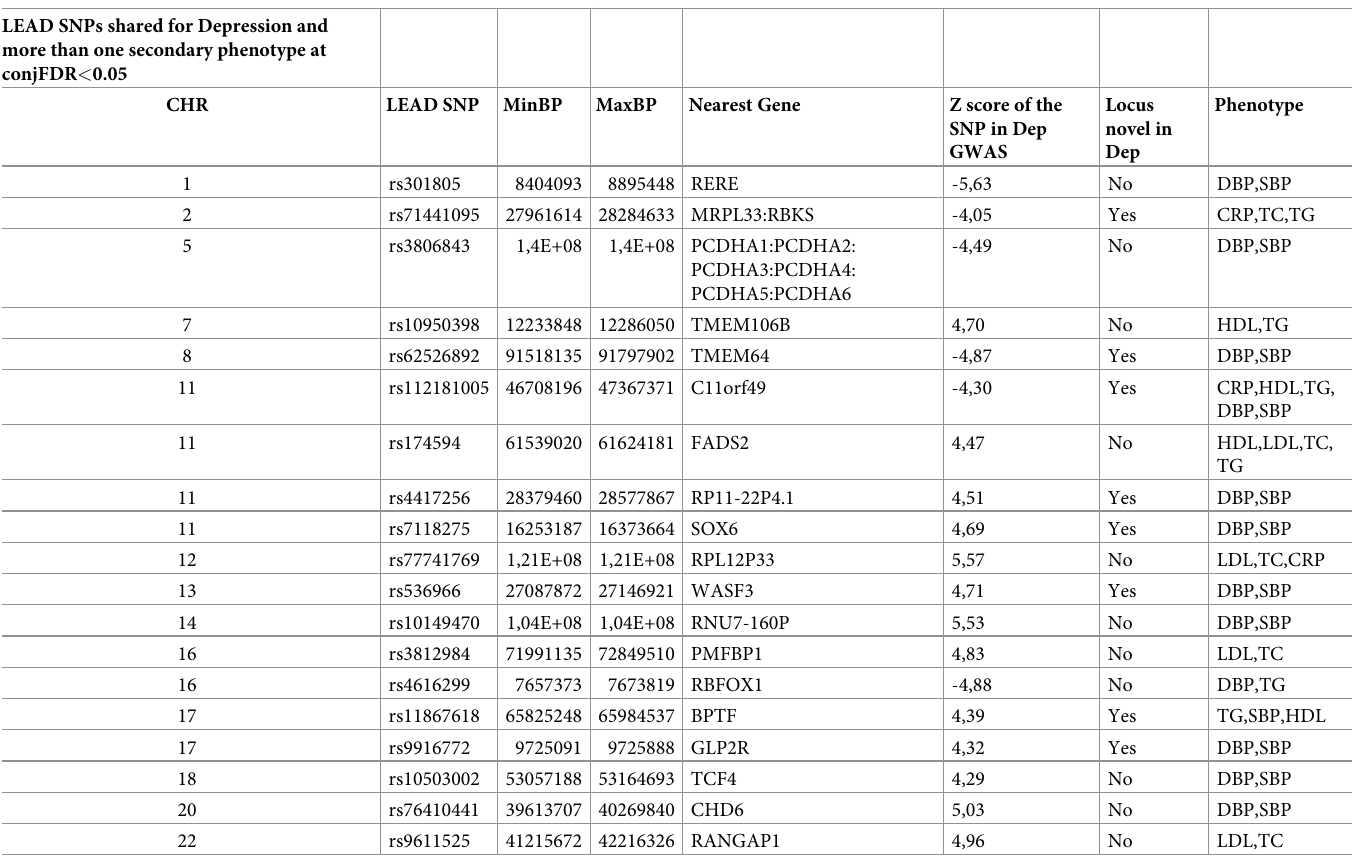
Table 2. Loci with common lead SNP for depression and more than one secondary phenotype. SNP; Single-Nucleotide Polymorphism, CHR; chromosome, MinBP; minimum base position, MaxBP; maximum base position, Dep; depression, CAD; coronary artery disease, T2D; type 2 diabetes, CRP; c-reactive protein, HDL; high-den- sity lipoprotein, LDL; low-density lipoprotein, TC; total cholesterol, TG; triglycerides, DBP; diastolic blood pressure, SBP; systolic blood pressure. LEAD SNPs shared for Depression and more than one secondary phenotype at conjFDR <